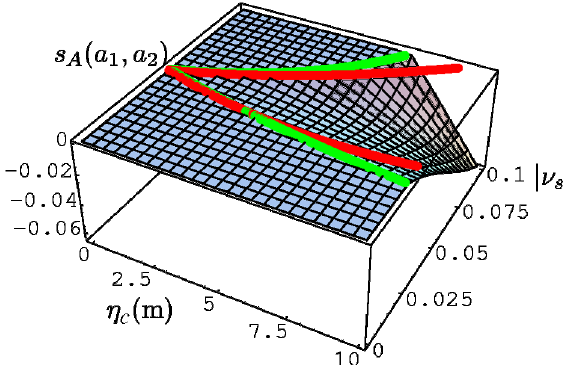
FIG. 1. (Color) Unstable region caused by dispersion at a cavity for (cid:28) close to an integer. Light green: border of stability; dark red: border of stability from the approximate Eq.